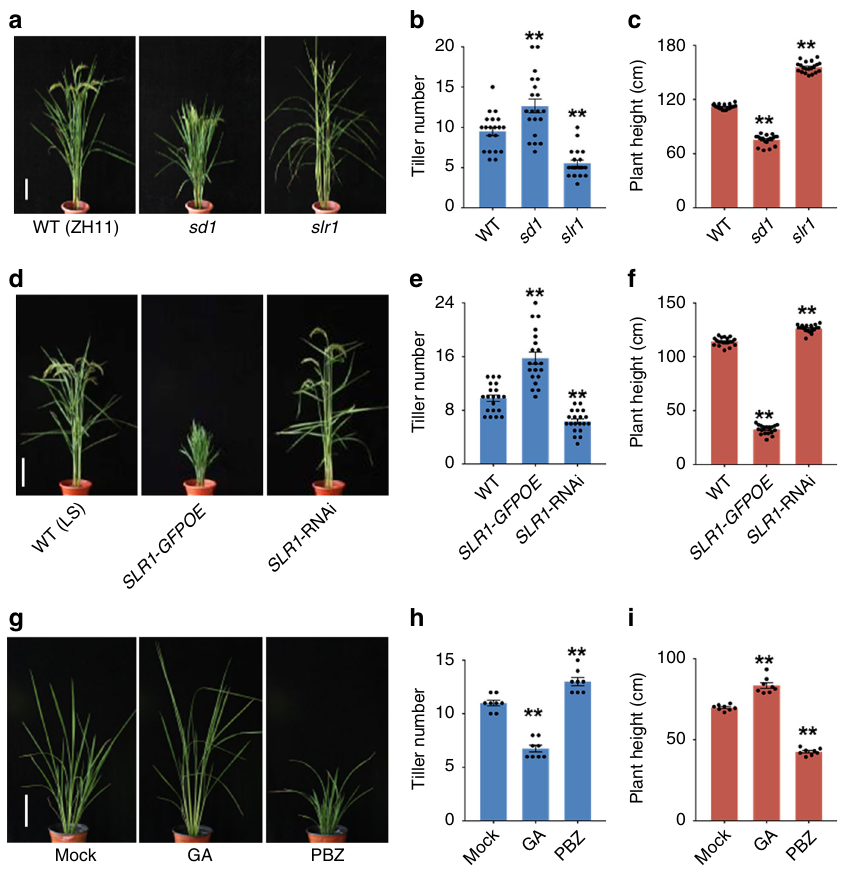
Fig. 1 Tiller number and plant height are coordinated inversely by GA. a Appearance of the wild-type (WT, ZH11) and GA-signaling mutants at the heading stage. Scale bar, 20 cm. b , c Tiller number ( b ) and height ( c ) of plants shown in ( a ). d Appearance of SLR1- transgenic plants at the heading stage. Scale bar, 20 cm. e , f Tiller number ( e ) and height ( f ) of plants shown in ( d ). g Appearance of WT plants after GA and PBZ treatments for 1 month. Scale bar, 20 cm. h , i Tiller number ( h ) and height ( i ) of plants shown in ( g ). Asterisks indicate signi fi cant difference to the WT or mock (two-tailed Student ’ s t test, ** p < 0.01; mean ± s.e.m., n = 20 in ( b , c , e , f ), and 8 in ( h ) and ( i ). Source data are provided as a Source Data fi